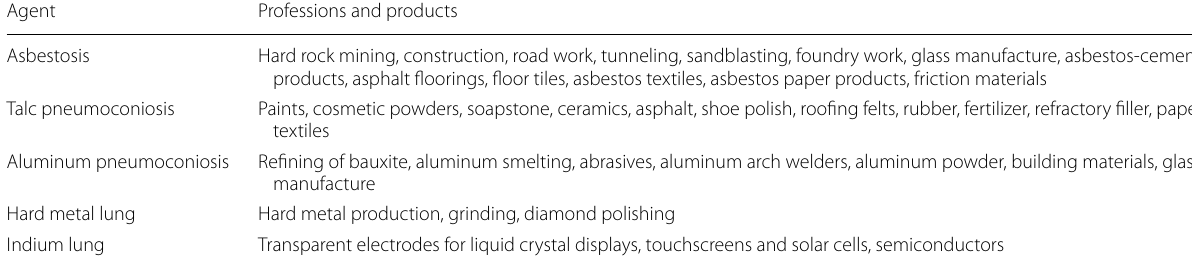
Table 1 Professions and products that have risk of exposure to each of the pneumoconiosis Agent Professions and products